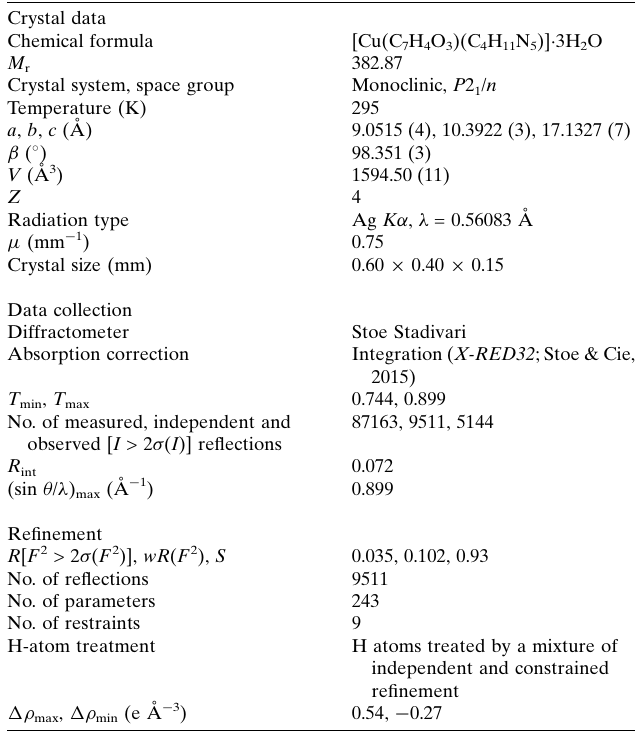
Table 2 Experimental details. Crystal data Chemical